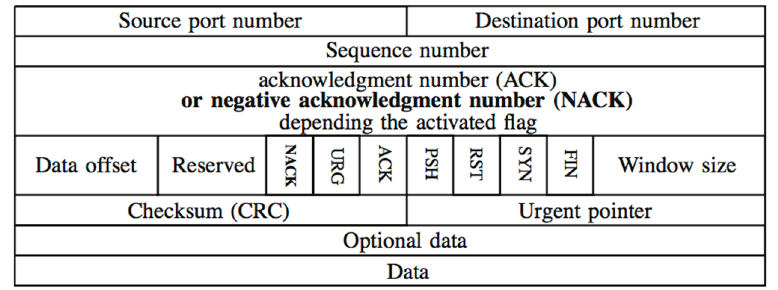
Figure 3. TCP-NACK header.